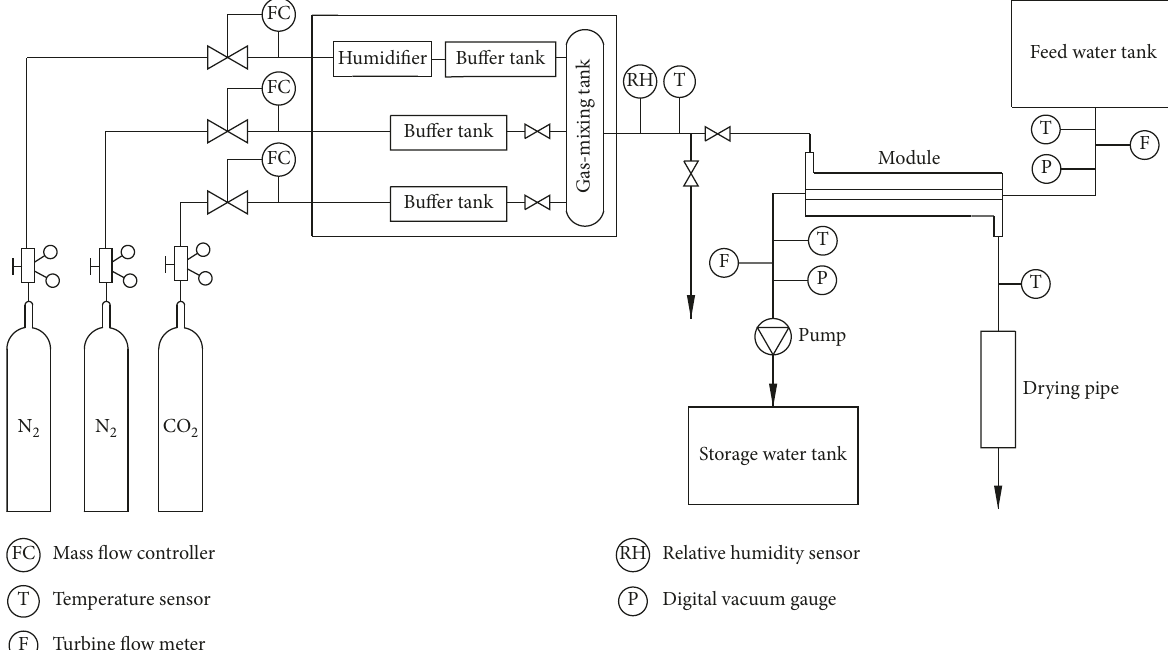
Figure 5: Schematic of experimental